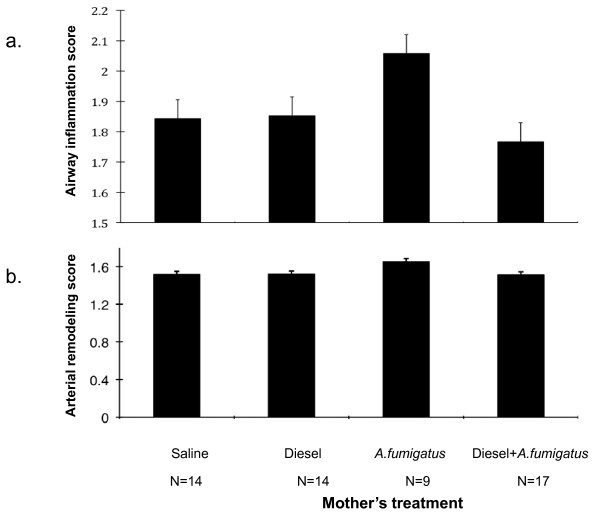
Perivascular, peribronchial airway inflammation and airway remodeling in offspring. a. Perivascular, peribronchial airway inflammation in offspring of A. fumigatus. Composite scores were obtained following 5 or 6 doses of A. fumigatus. Significant differences across groups were not detected. p = 0.11 on ANOVA. Perivascular and peribronchial inflammation were scored as follows [13]: 1 = normal with very few inflammatory cells bordering the arteries or airways; 2 = scattered inflammatory cells surrounding the artery or airway up to two rings in depth; 3 = cell cuffs or clusters of inflammatory cells surrounding the artery or airway three rings or more in depth. b. Arterial remodeling in offspring. Offspring from mothers treated during pregnancy as outlined in Fig. 1 were exposed to A. fumigatus intranasally with 5-6 doses starting at 9-10 weeks of age. Arterial remodeling was scored as described [13] and in Figure 3b. Significant differences across groups were not detected. p = 0.183 on ANOVA. Arterial remodeling was scored as follows [13]: 1 = normal; 2 = thickened vascular wall with intact lumen and circular media; 3 = obstructed lumen and thickened wall lined with disorganized layers of cells.